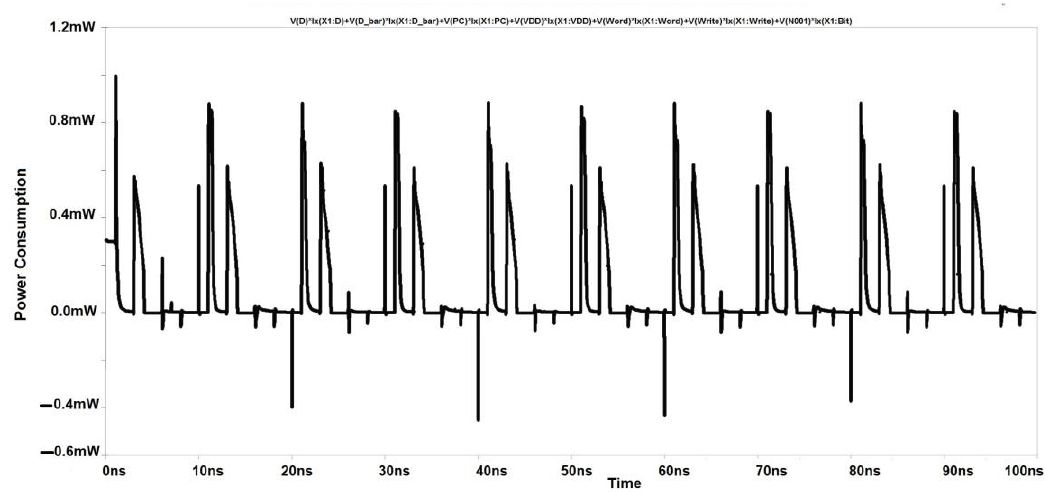
Figure 11. Power Consumption Spectrum of Cross Coupled Sense Amplifier.